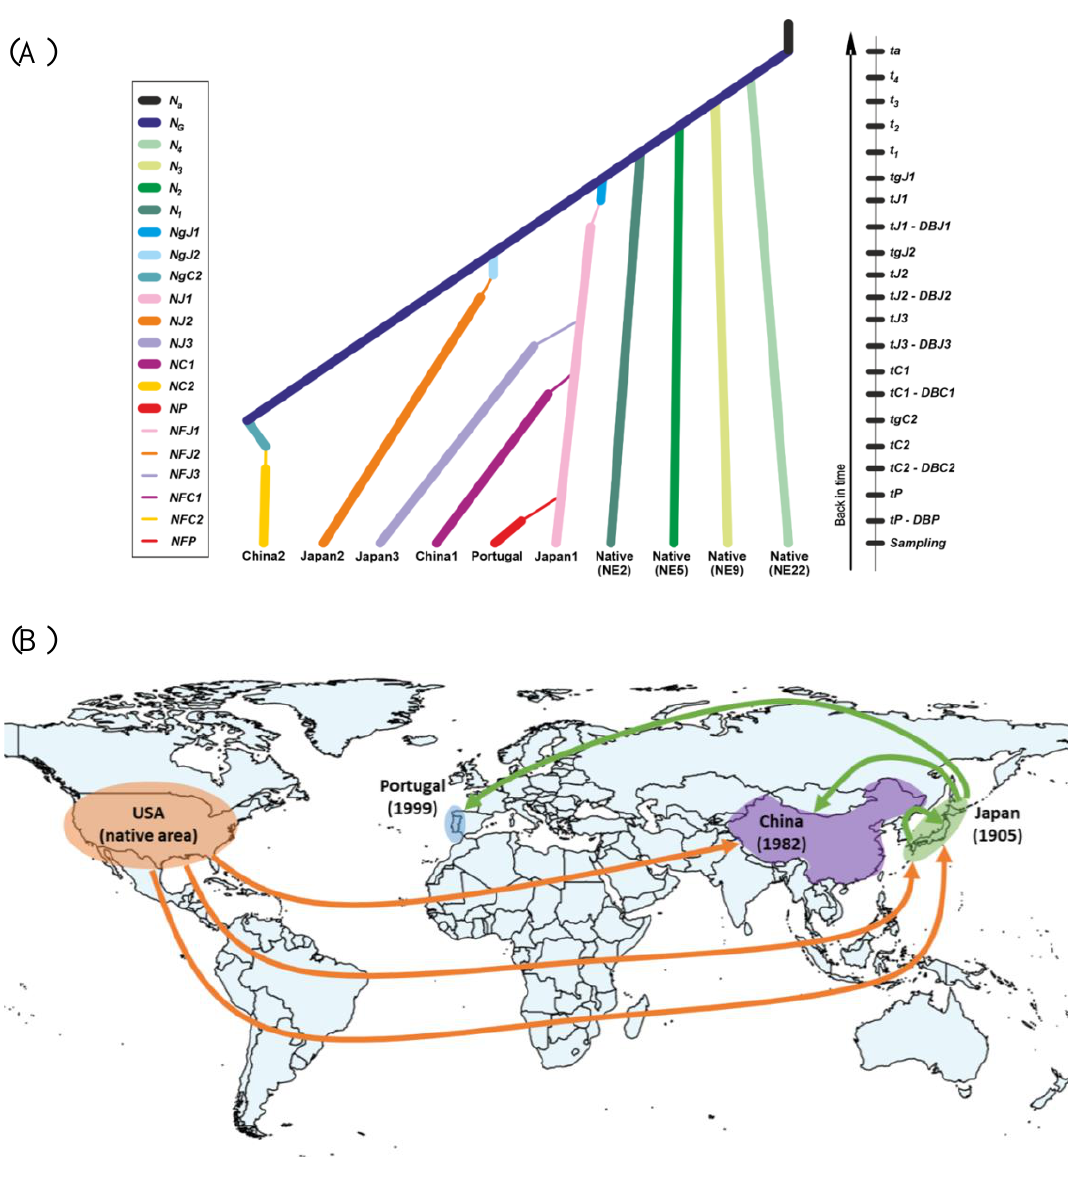
Figure 3: Worldwide invasion routes of the pinewood nematode as inferred from ABC-RF analyses. (A) Graphical illustration of the final selected scenario (step 6, scenario1); (B) Geographic representation of final selected scenario. The year of first infestation for every invaded area is indicated in parenthesis. For each step, the use of an alternative prior set, a smaller time scale (15 generations/year) or a larger time scale (45 generations/year) essentially confirmed the main results. The exceptions were for steps 1 and 3 for which one analysis out of four provided the largest number of votes for a different scenario (Table S2). The prior error rates appeared moderate for all the analyses (Table 3, Table S2), reflecting a decent, albeit imperfect, ability to distinguish between competing scenarios. Finally, the model checking analysis showed that posterior simulations of the final selected scenario were able to produce data close to the observed ones: none of the 760 observed SuSts were in the extreme 5% tails of the distribution of simulated SuSts after correction by the false discovery rate method, whatever the prior set or time scale used (Table